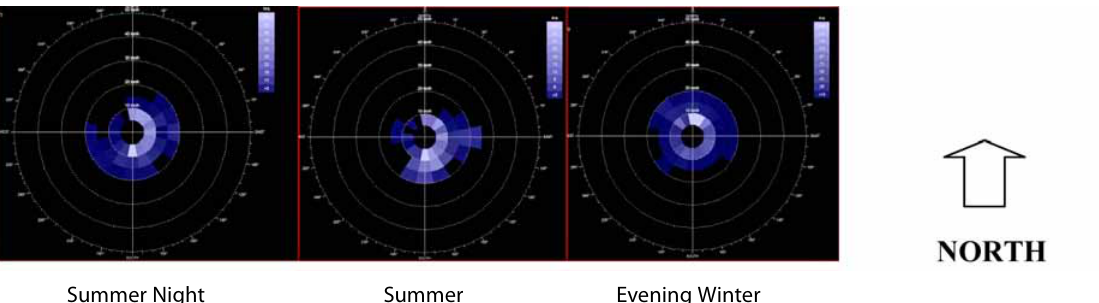
fig. 15. Prevailing wind direction: from South side in summer & from north side in winter in ranchi Note: white portions show predominant wind